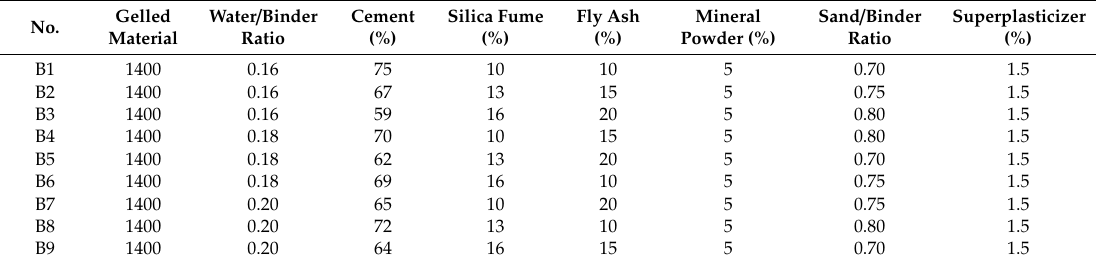
Table 8. Orthogonal test mix